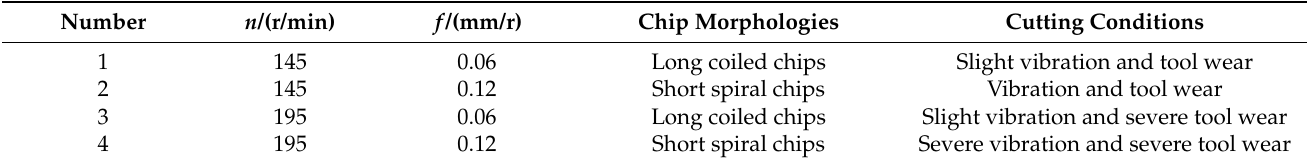
Table 3. Machining results under different process